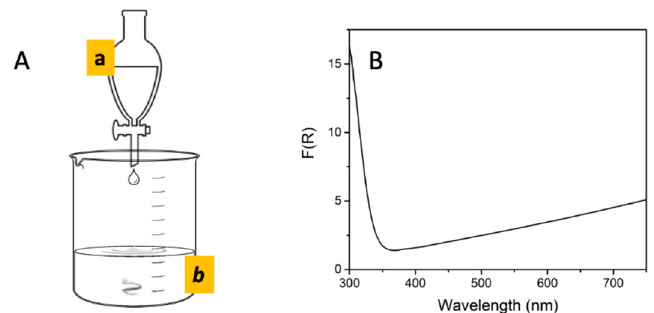
Figure 1. ( A ) Schematic representation of the synthetic set up: (a) dropping funnel containing the TiOSO 4 0.64 M water solution dripping in (b) NH 4 HCO 3 2 M water solution. ( B ) DR spectrum